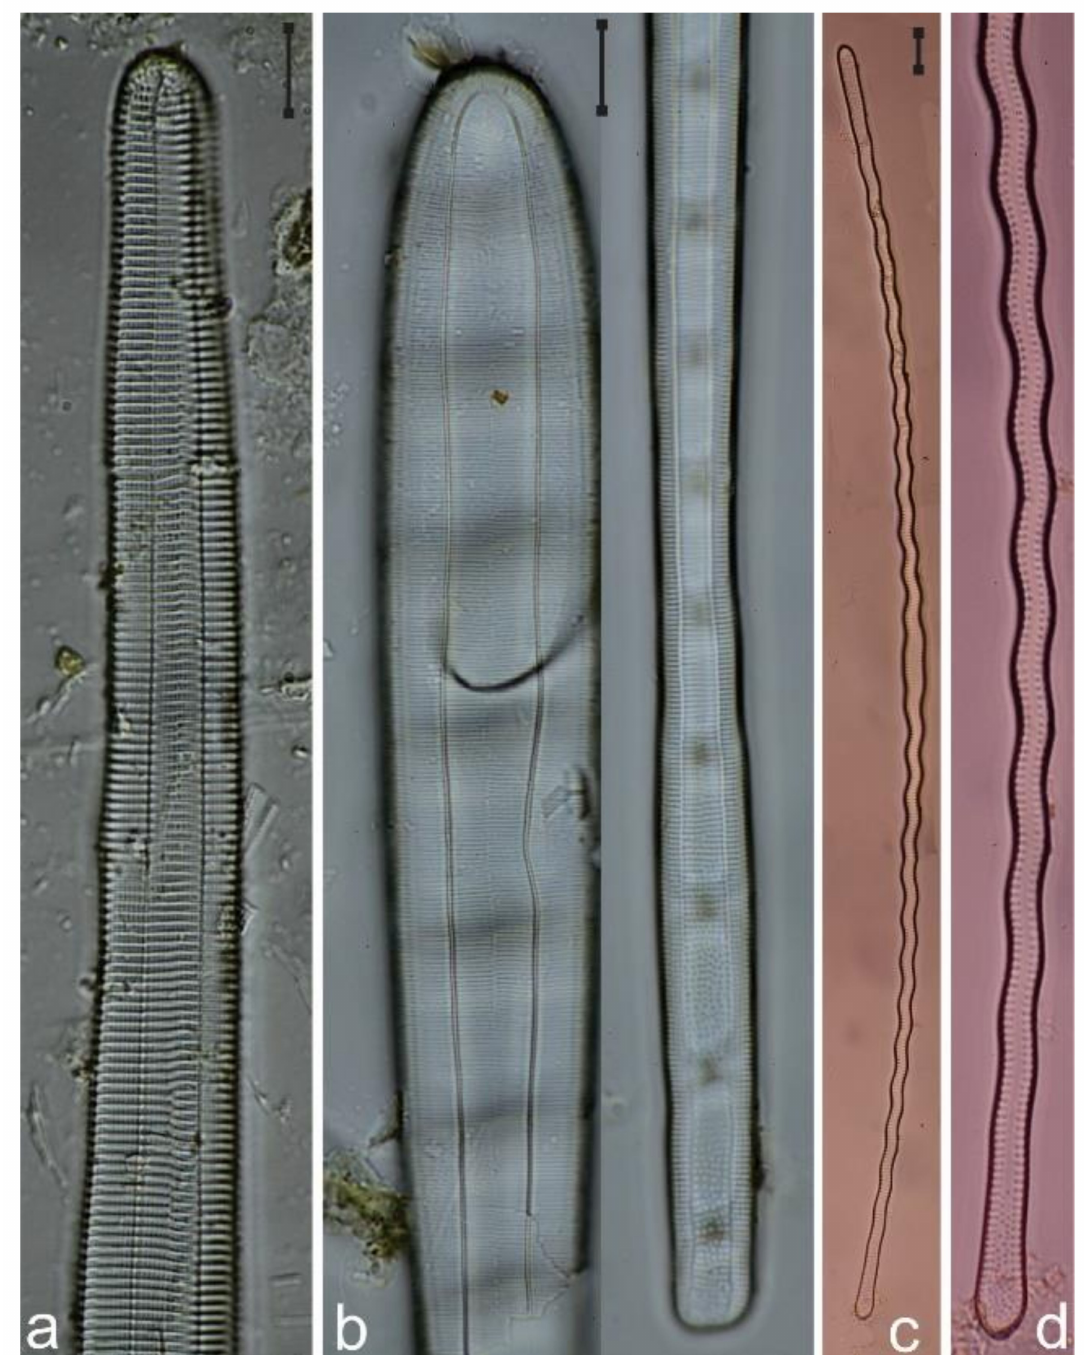
Figure 18. ( a ) Ardissonea formosa ; ( b ) Climacosphenia elongata ; ( c , d ) Toxarium undulatum . Scale bar = 10 µ